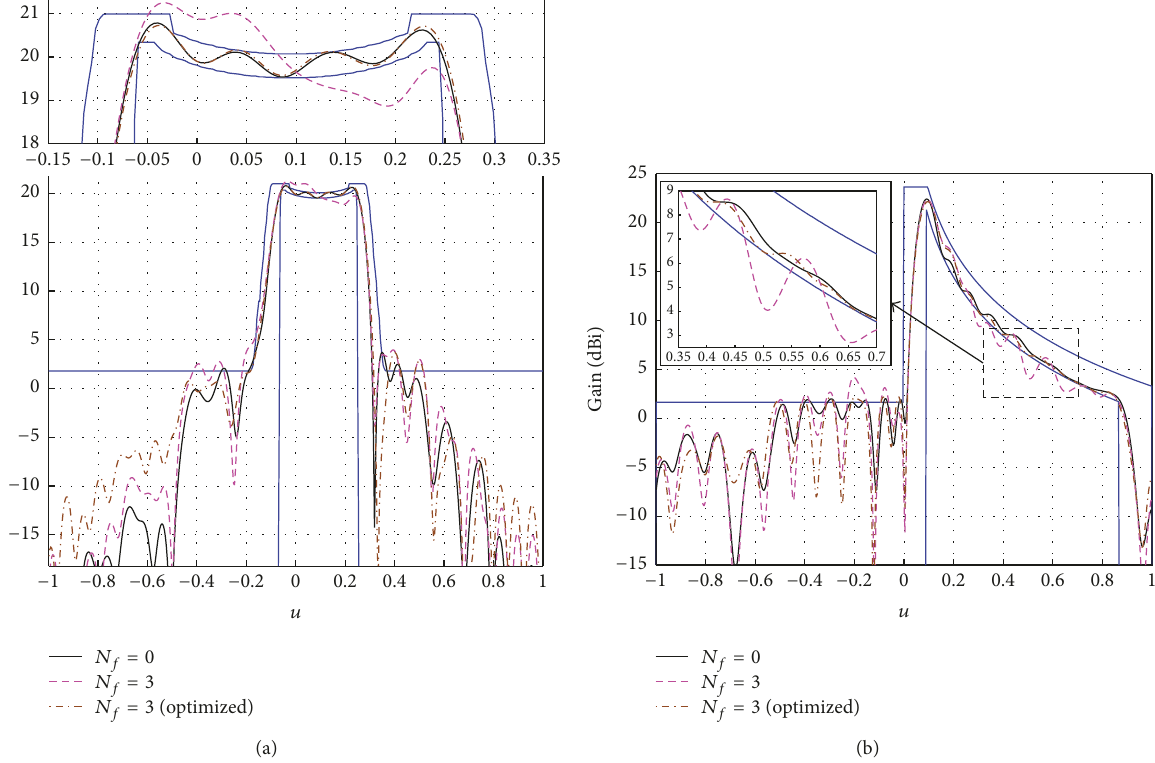
Figure 8: Comparison of the simulations between the reflectarray with frame taken into account in the synthesis and without frame, for 𝑋 polarization. 𝑁 𝑓 indicates the number of extra elements added as dielectric frame at each edge of the reflectarray. (a) Asymmetric cut of isoflux pattern. (b) Elevation cut of LMDS